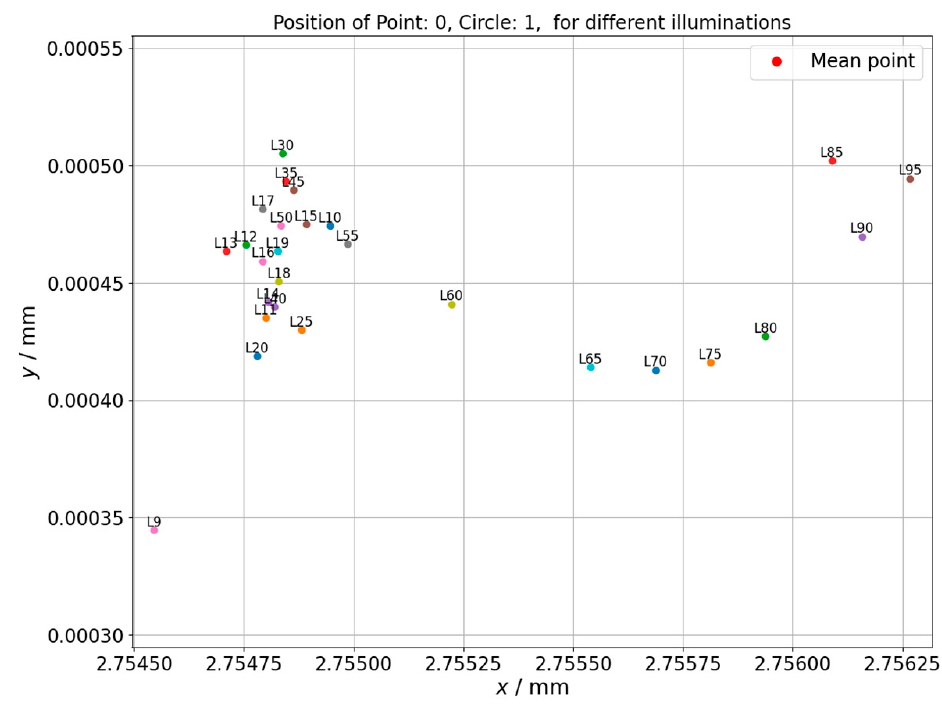
Figure 9. Changes of position of measured point depending on the applied backlight. Hole plate standard measurement. Circle 1.